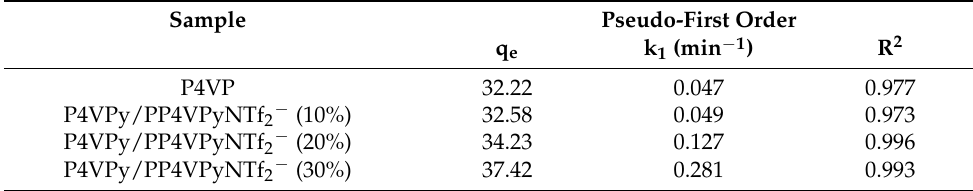
Figure 6. XPS survey spectra of P4VPy/PP4VPyNTf 2 − nanofibers ( A ) before and ( B ) after the adsorp- adsorption of gold ions. tion of gold ions. Table 2. Adsorption kinetics parameters for Au (III) adsorption onto Table 2. Adsorption kinetics parameters for Au (III) adsorption onto nanofibers.